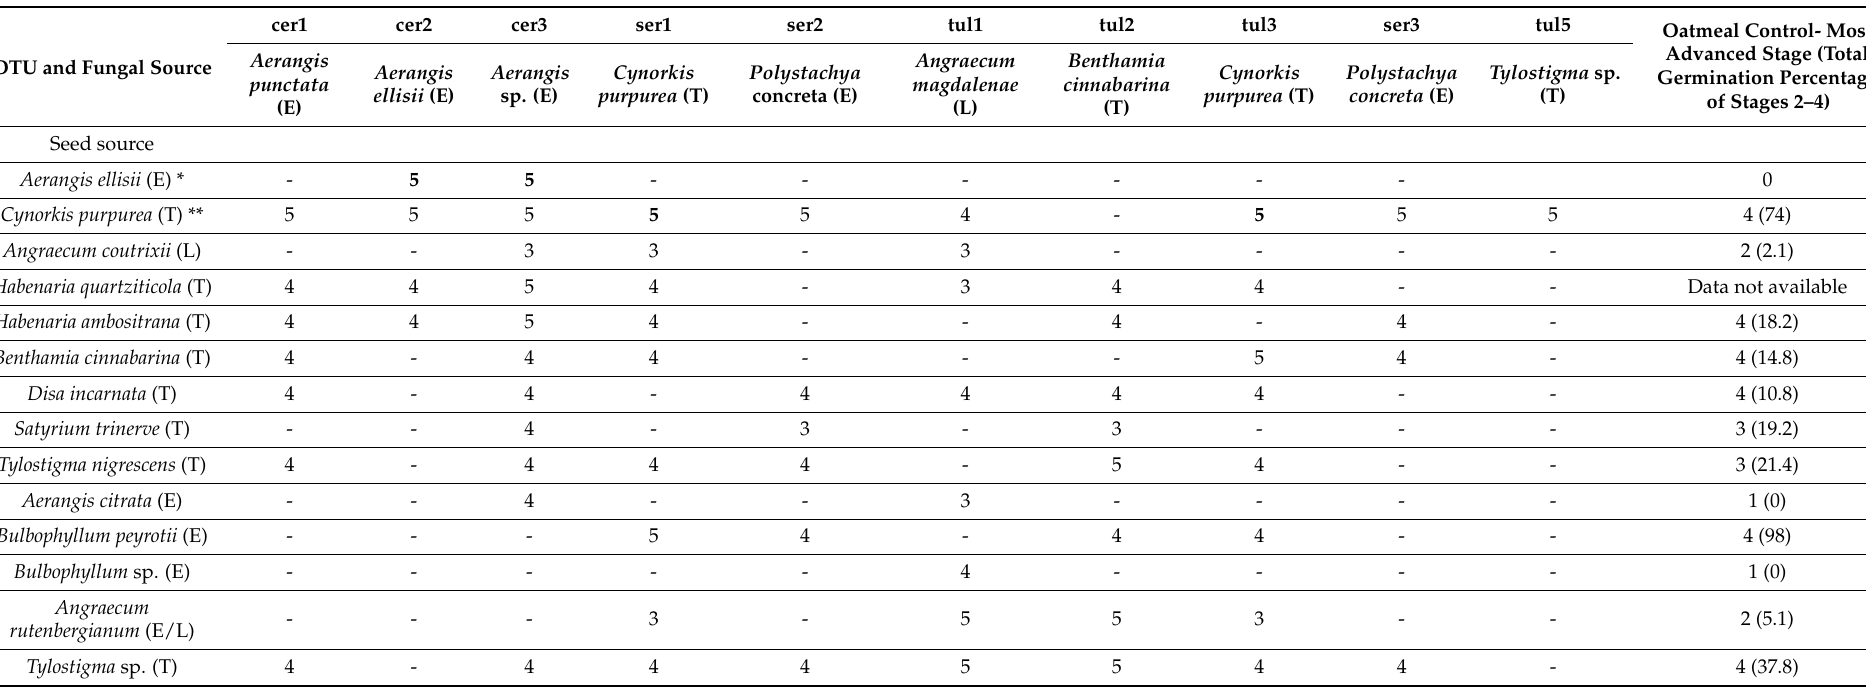
Table 3. Epiphytic (E), lithophytic (L), and terrestrial (T) seed sources (14 taxa), fungal source (nine taxa covering all three life forms), and germination stages reached by the seeds after 12 weeks. Number 5 represents seedling development (bold number 5 represents germination with own mycorrhizal fungus).